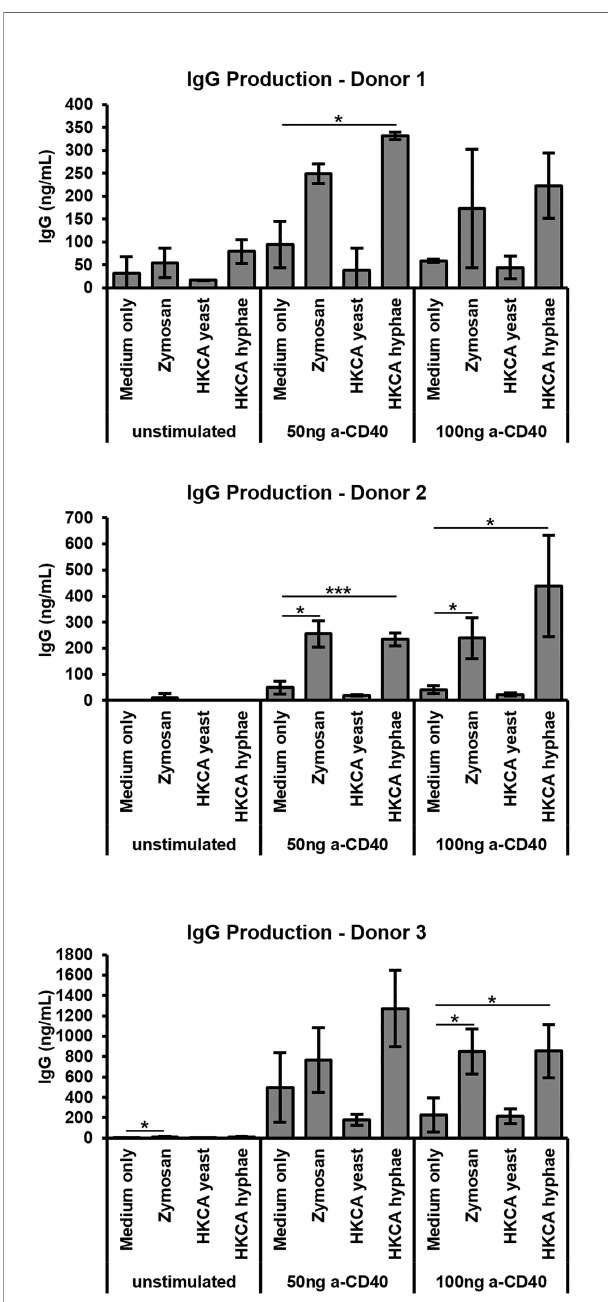
FIGURE 5 | StimulationofhumanBcellswithZymosanandHKCAhyphaeleads toincreasedantibodyproduction.Bcellsfrom humanperipheralbloodwere culturedfor 6daysunstimulatedor stimulatedwithdifferentanti-CD40 concentrations, anti-IgA/IgG/IgM,IL-2andIL-10inthepresenceofZymosan, HKCAyeastorHKCAhyphae.For eachdonor, sampleswereanalysedin triplicates.Datarepresentmean±standarddeviation(SD). *p<